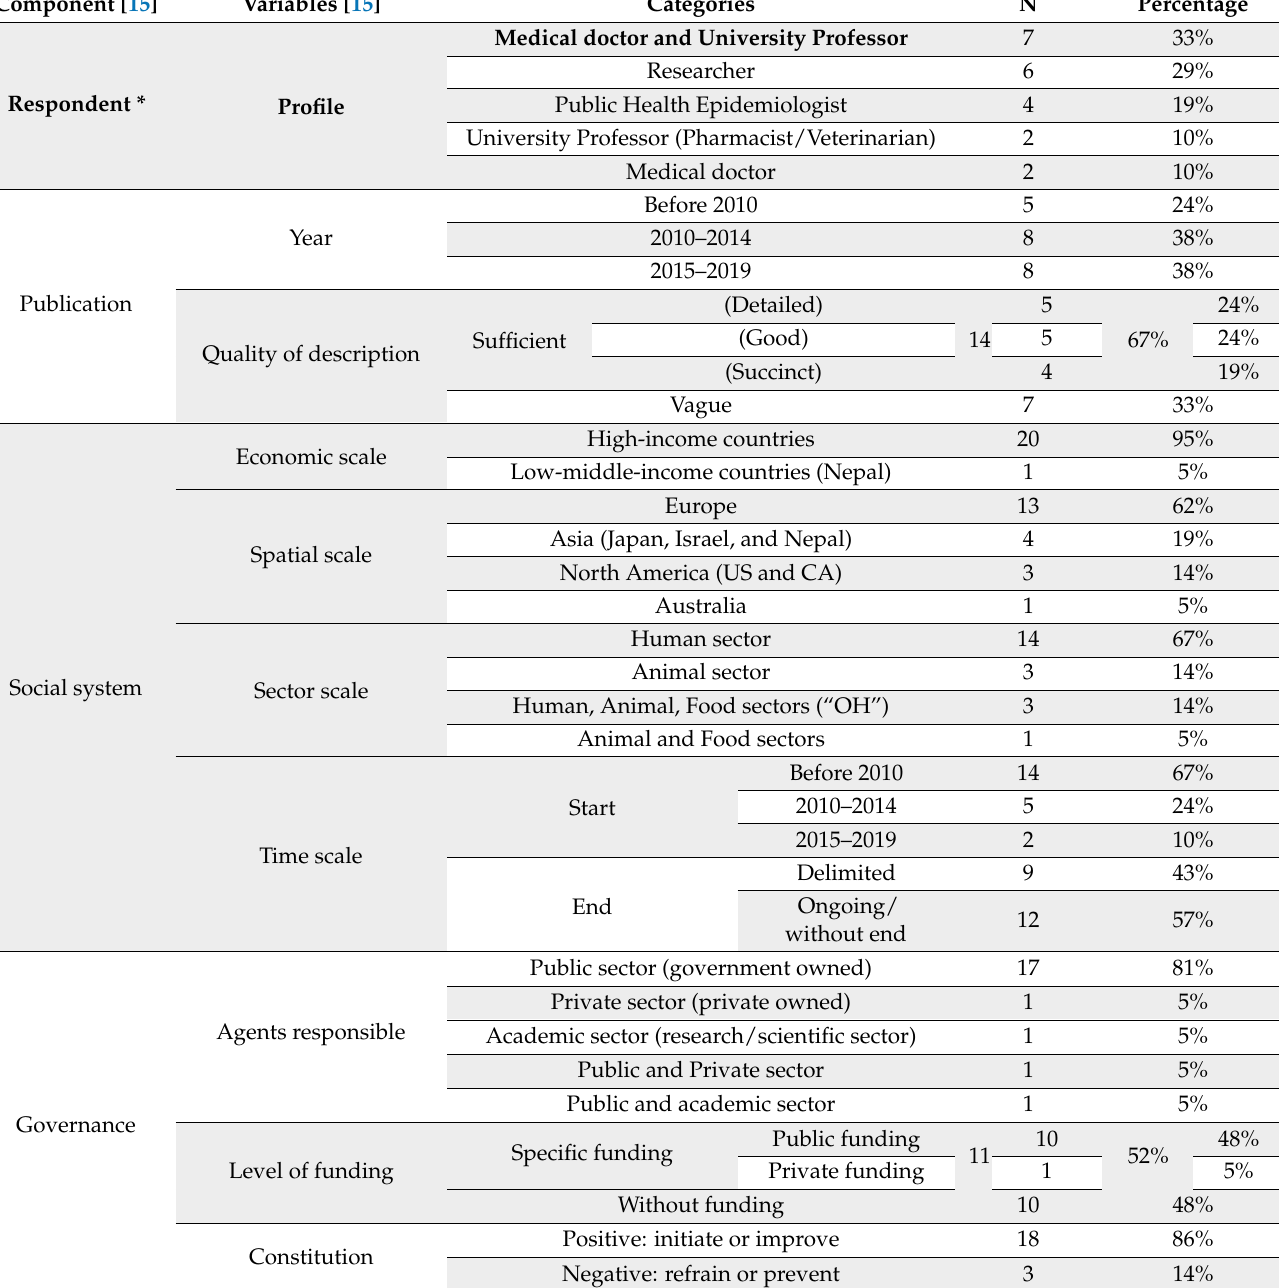
Table 1. Background information extracted from the 21 interventions using the AMR- Intervene framework [15]. * Component not inside of the AMR-Intervene framework